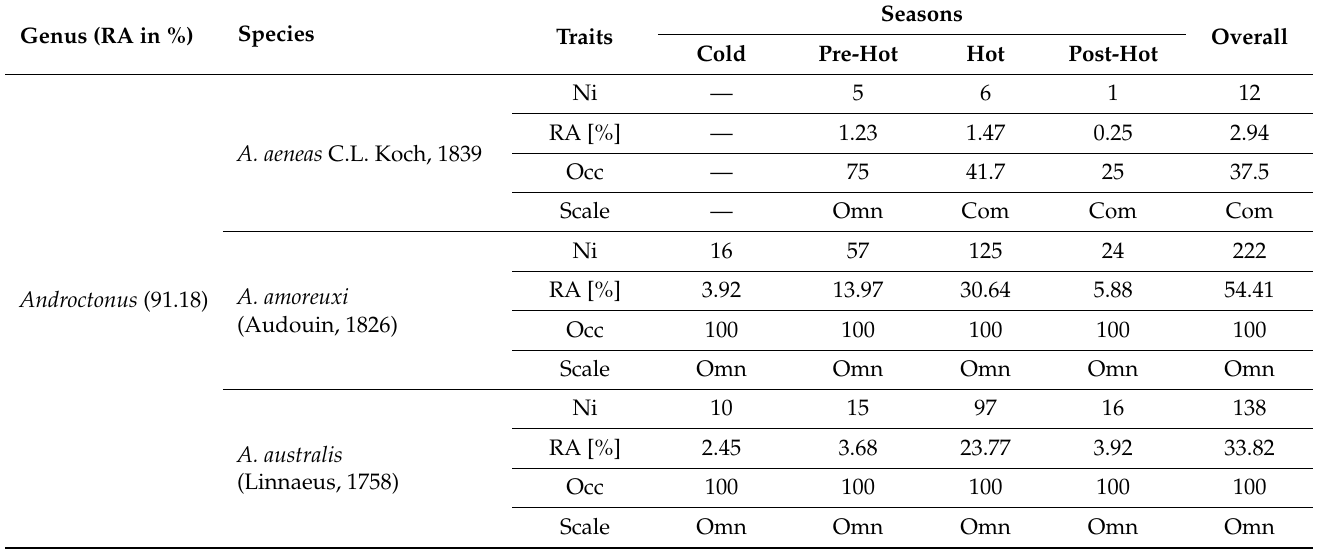
Table 1. Species list, abundance and occurrence frequency of scorpion species captured in the Ghardaïa region, Algeria